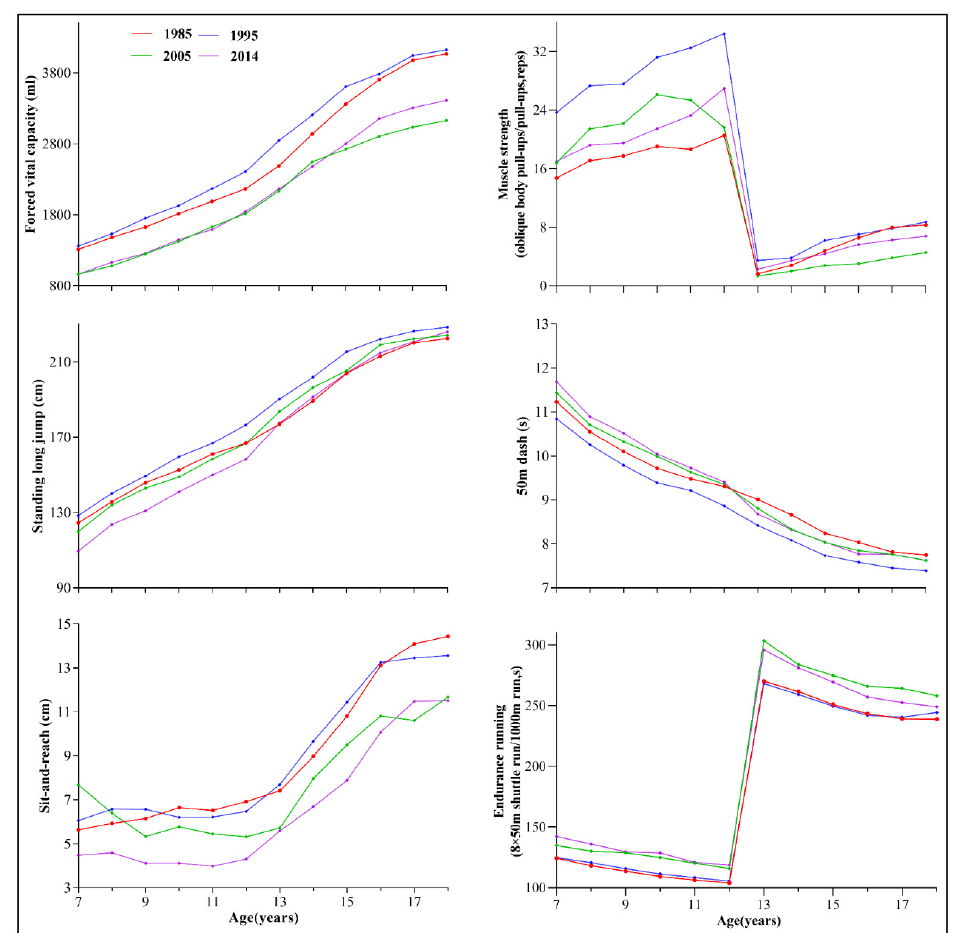
Figure 1. Trends in the six core items of physical fitness among boys aged 7–18 in Xinjiang, from 1985 to 2014.